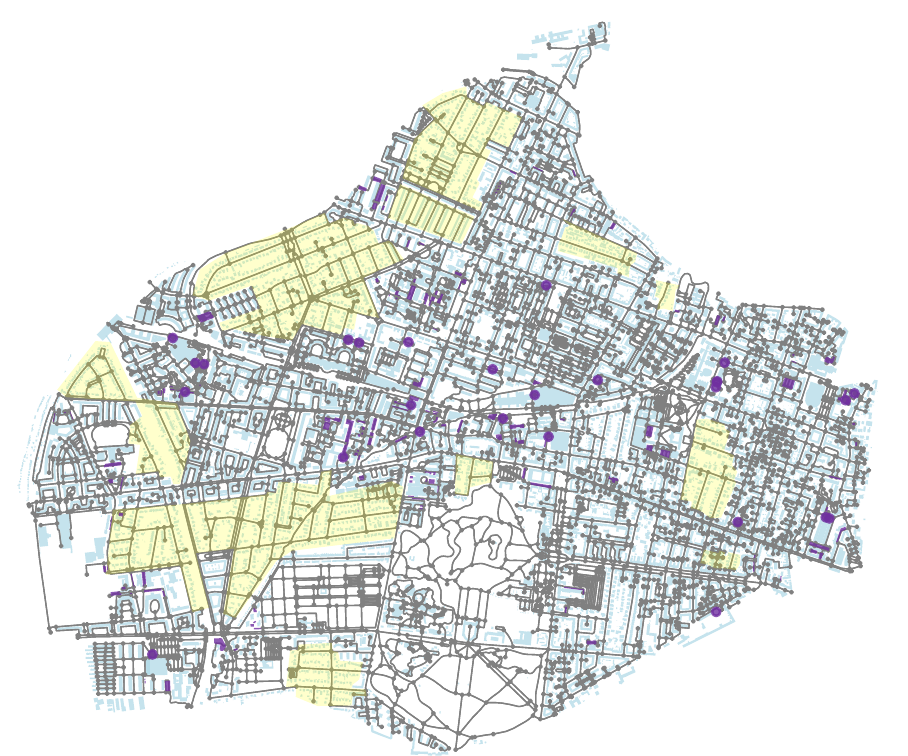
Figure 4. Visualization of the municipality of Frederiksberg, with gray lines indicating roads and walking paths, and buildings represented in light blue. The identified residential housing areas with predominantly single-family houses are highlighted with a yellow shade, and the primary workplace parking areas are represented in a purple shade.